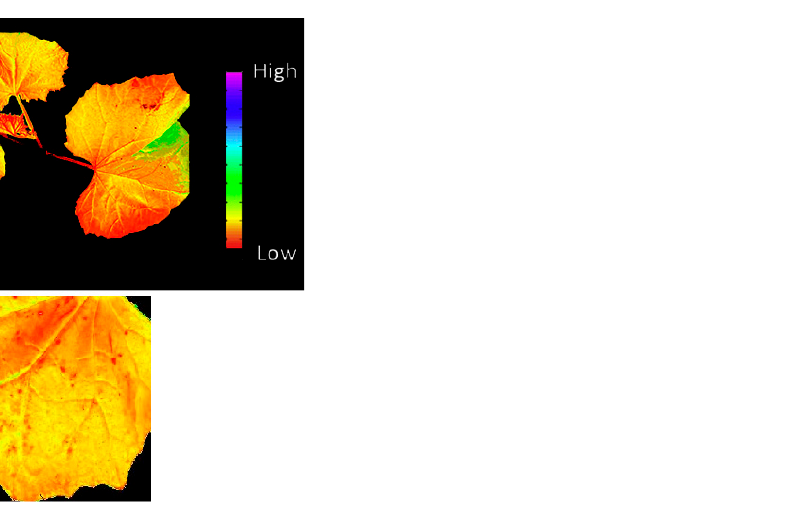
Figure 5. False color image of fluorescence parameter Y(II) on different planting days.